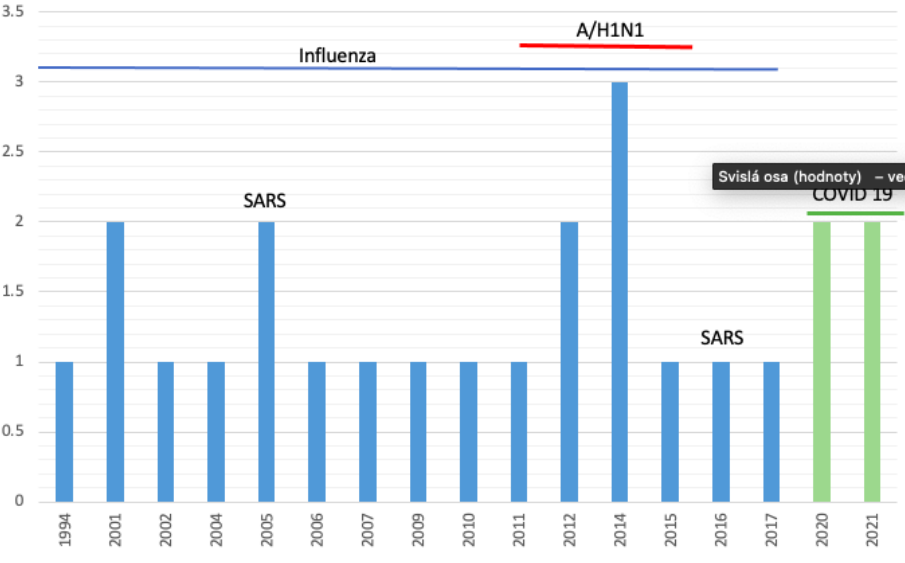
Figure 3. Year of issue and